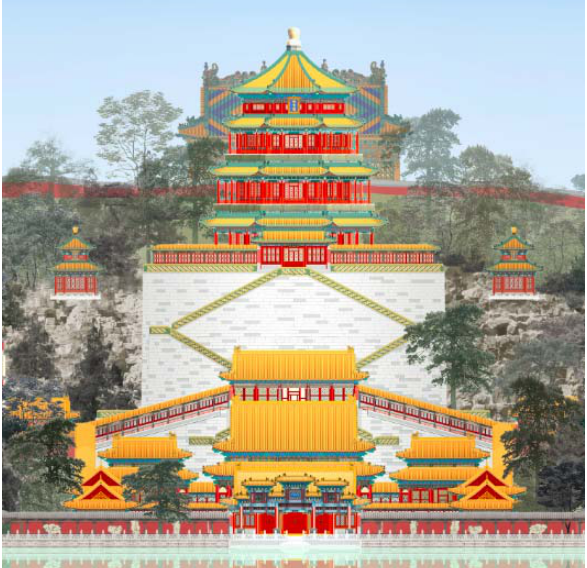
Fig.12. A coloured elevation of the Paiyun Hall 排云殿 Group, 2007